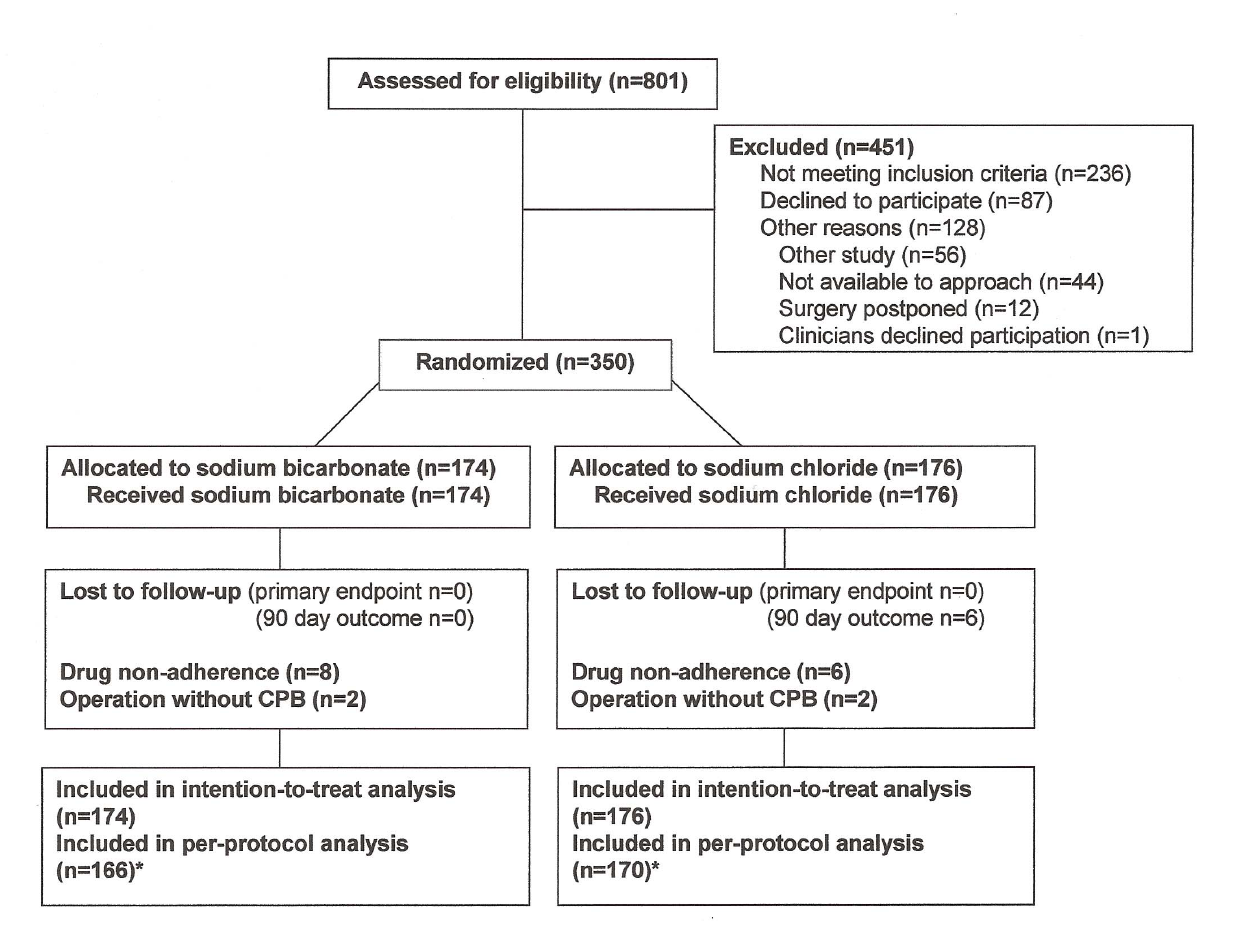
Figure 1. Patient flow through the study reported in a CONSORT [ 11 ] diagram. *Per protocol analysis excluded patients who were not operated on cardiopulmonary bypass or who were not drug-adherent. In both study groups there were two patients meeting both criteria. Six patients were lost to follow-up (all in the sodium chloride group). Major reasons for a patient to be lost to follow-up at 90 d were (i) patient came for open heart surgery from a foreign country and did not respond to contact attempts ( n =3) or (ii) patient was socially disadvantaged and did not provide a contact address or telephone number and did not visit their general practitioner or cardiac outpatient department for postoperative follow up ( n =3). CPB, cardiopulmonary